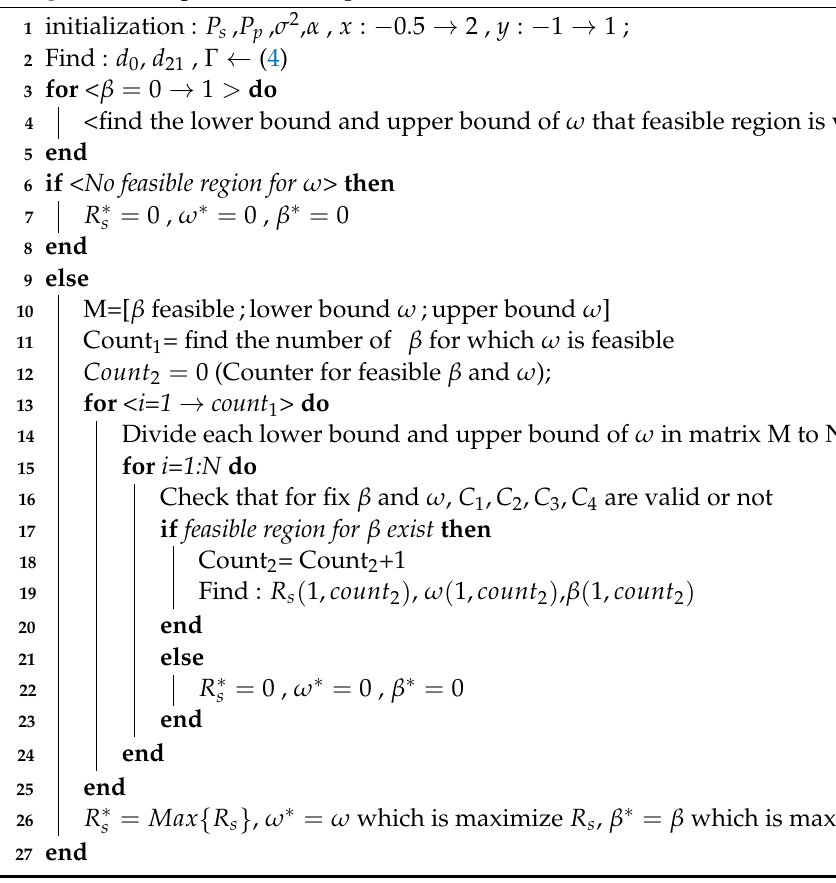
Algorithm 1 Optimization Algorithm for